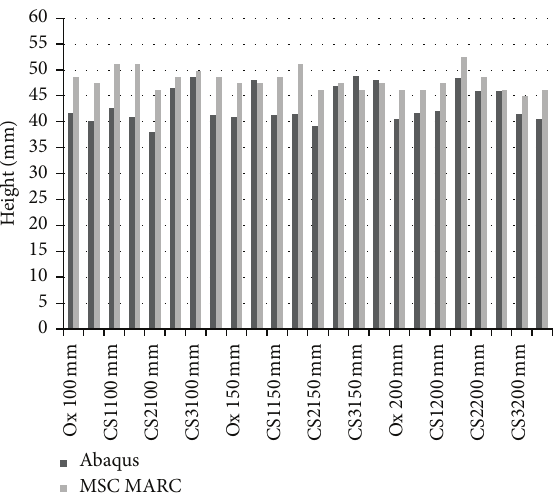
Figure 28: Maximum height for the Nakajima tests: comparison between MSC-MARC and Abaqus.